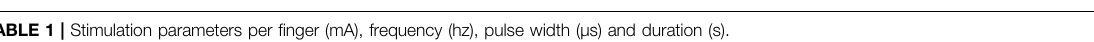
TABLE 1 | Stimulation parameters per fi nger (mA), frequency (hz), pulse width (µs) and duration (s).